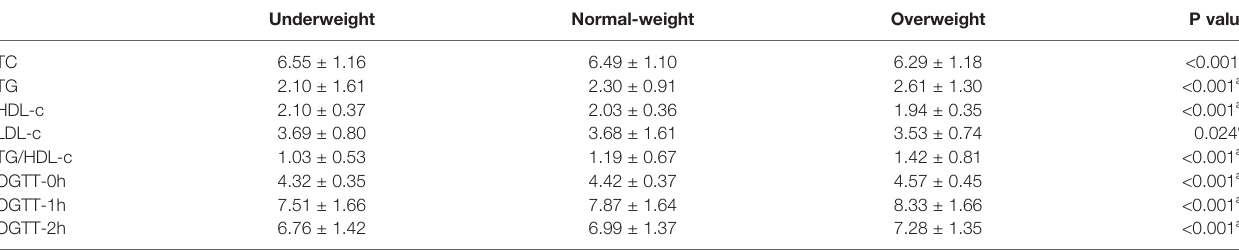
TABLE 2 | Maternal biochemical markers during second trimester strati fi ed by pre-pregnancy BMI. Underweight Normal-weight Overweight